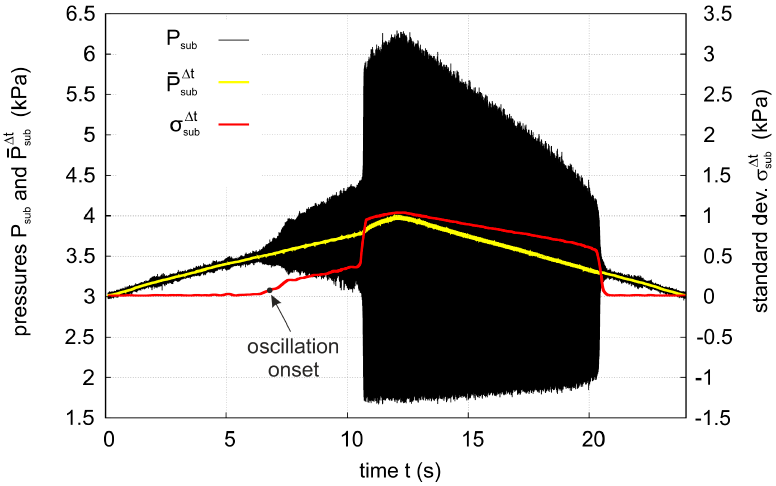
Figure 7. (Color online) Subglottal pressure (black), its moving average (yellow), and its standard deviation (red) during one cycle of the variable flow rate.